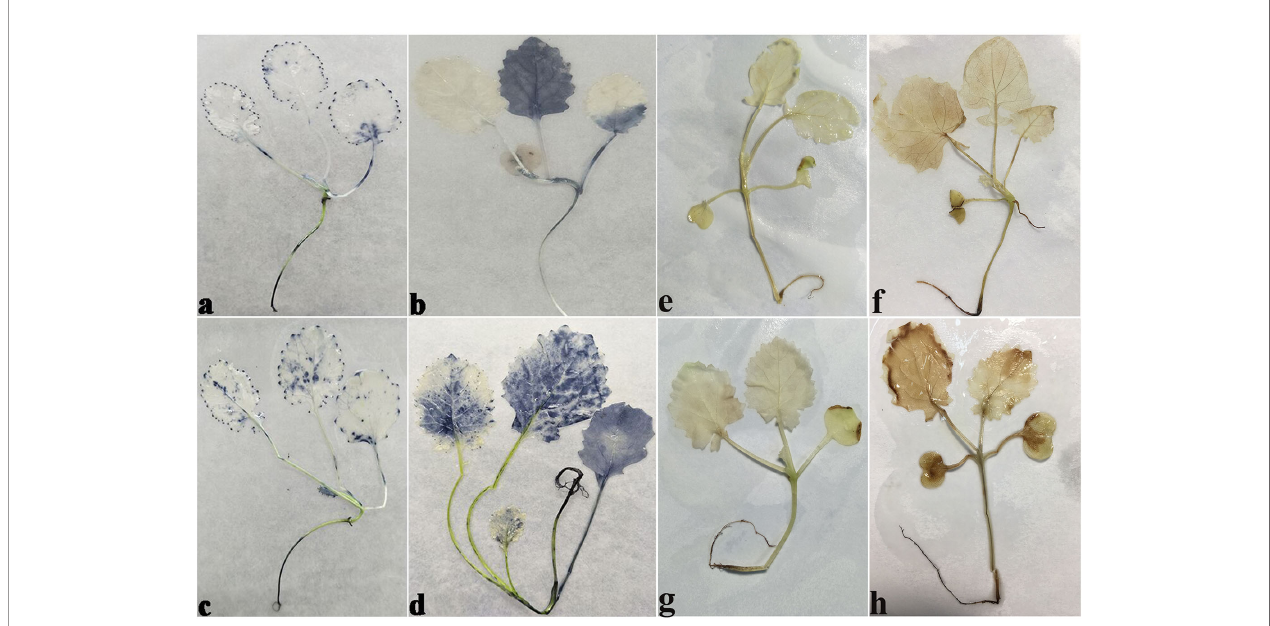
FIGURE 4 | The O 2 − (A-D) , H 2 O 2 (E-H) levels in seedlings stained with Nitrotetrazolium blue chloride (NBT) and 3, 3 ʹ -Diaminobenzidine (DAB) of cultivars 16NTS309 and Tianyou2238 under non-cold (A, C, E, G) and cold stress (B, D, F, H) conditions. B. napus cultivars 16NTS309 (A, B, E, F) and Tianyou2238 (C, D, G, H)